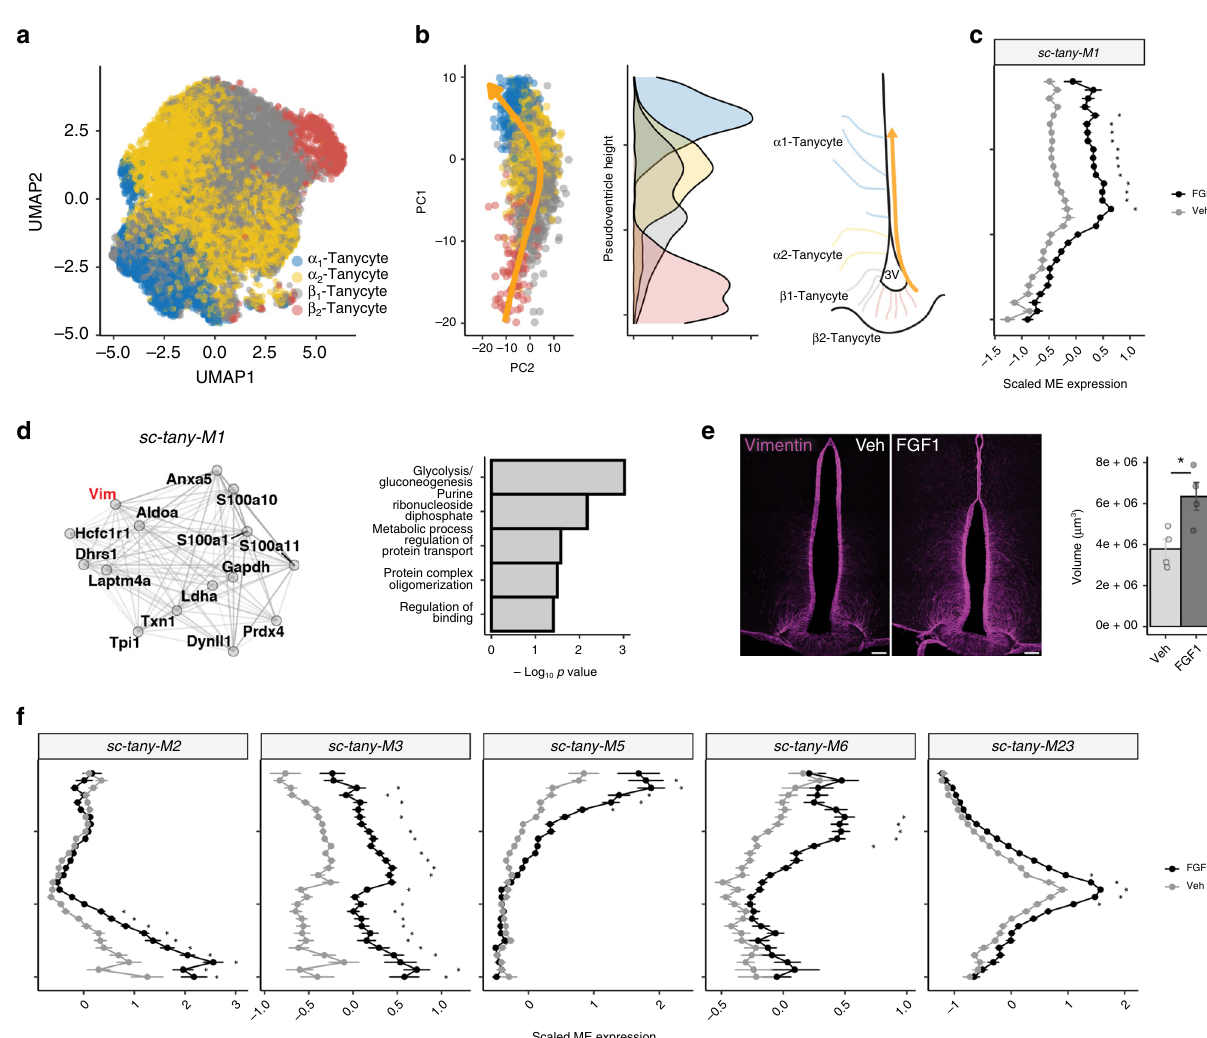
Fig. 2 Tanycyte module expression maps to the spatial distribution lining the third ventricle. a UMAP clustering of tanycytes ( β 2-, β 1-, α 1-, α 2- Tanycytes) from the Day 5 single-cell RNA-sequencing (scRNA-seq) dataset. Cell type annotations were inferred from a published dataset 16 . b Tanycyte lineage cells plotted on principal components 1 and 2 revealed a trajectory (left). The colors represent the subtype of each cell from a . A principal curve fi t across the trajectory was used to assign a pseudoventricle score to each cell corresponding to the spatial location of that cell type along third ventricular (3V) wall. Density plot of each tanycyte subpopulation plotted along the pseudoventricle revealed a continuum of gene expression and non-distinct shifts in the expression of marker genes along the pseudoventricle. c Scaled module expression of sc-tany-M1 in FGF1-treated (black) and vehicle (gray) tanycytes (linear mixed-effects model; bin size of 1; mean ± SEM; * p < 0.05) (Bonferroni adjusted) from the Day 5 scRNA-seq dataset ( n = 6 mice/group). Exact adjusted p values are provided in Supplementary Data 5. ME module eigengene. d Gene – gene network plot of the correlation of top 15 genes in module sc- tany-M1 (left) and associated pathways (right). Genes mentioned in the text are labeled in red. e Representative images of immunolabeling of vimentin in diabetic Lep ob/ob mice 1 week after vehicle or icv FGF1 injection. Pixel dimensions: 0.27 × 0.27 × 2.00 microns. Quanti fi cation: dots represent volume of vimentin-positive voxels assessed by iMARIS for individual animals (mean from 2 sections per animal, n = 4/group), mean ± SEM. Unpaired t test, two tailed, * p = 0.022 (not adjusted). Source data are provided as a Source data fi le. f Scaled module expression of sc-tany-M2 , sc-tany-M3 , sc-tany-M5 , sc-tany- M6 , and sc-tany-M23 with 5 consecutive points of difference in expression along the pseudoventricle between FGF1-treated (black) and vehicle (gray) tanycytes (linear mixed-effects models; bin size of 1; mean ± SEM; * p < 0.05) (Bonferroni adjusted) from the Day 5 scRNA-seq dataset ( n = 6 mice/group). Exact adjusted p values are provided in Supplementary Data